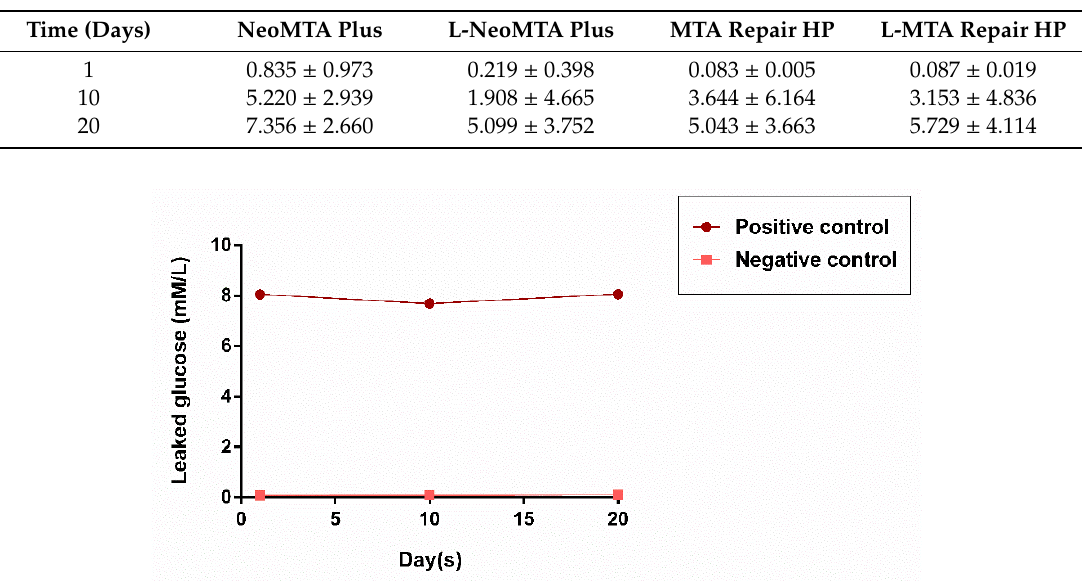
Table 2. Mean and standard deviation values of leaked glucose in four experimental groups (mM/L).